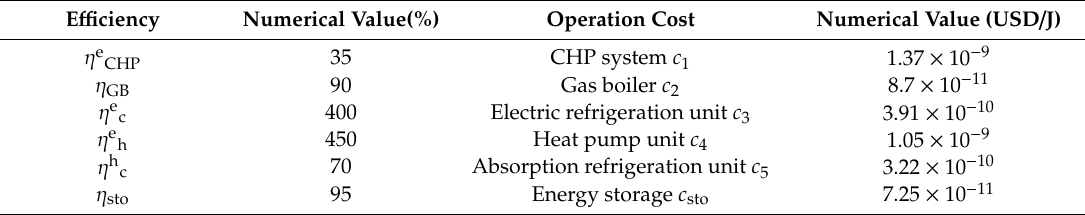
Table 1. E ffi ciency and operation cost of equipment in the park. Table 1. Efficiency and operation cost of equipment in the park.